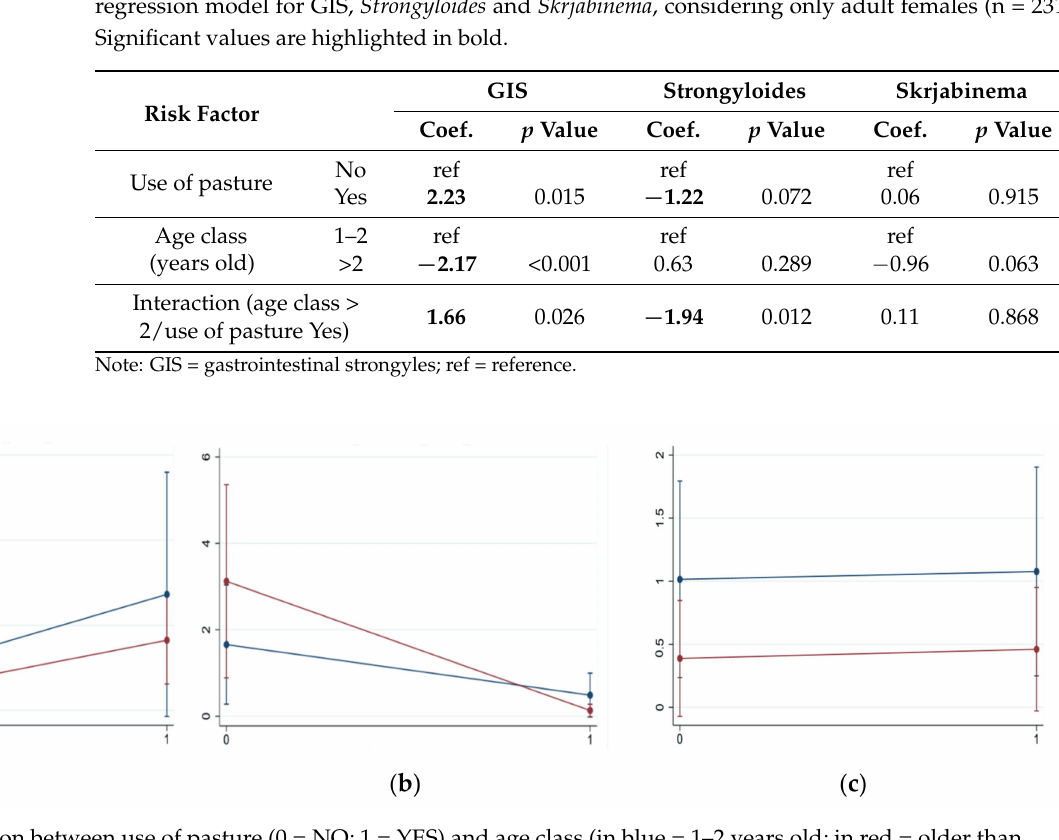
Figure 2. Interaction between use of pasture (0 = NO; 1 = YES) and age class (in blue = 1–2 years old; in red = older than 2 years of age) in the negative binomial regression model for GIS ( a ), Strongyloides ( b ) and Skrjabinema ( c ) conducted for adult females (n = 231). In y -axis the actual counts at McMaster observation (i.e., EPG/20) are